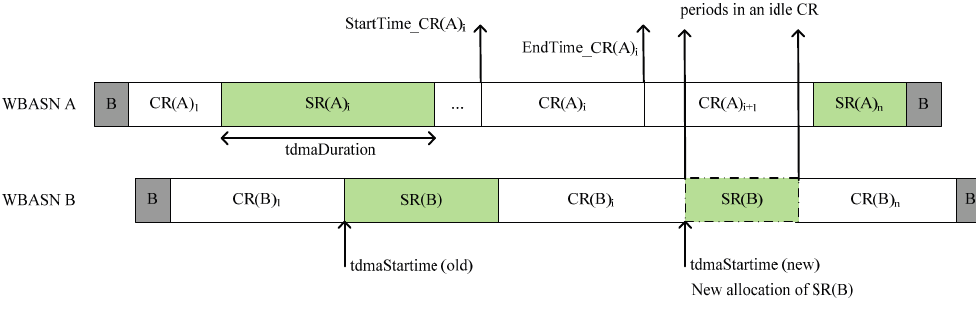
Figure 5. An example of the SRR